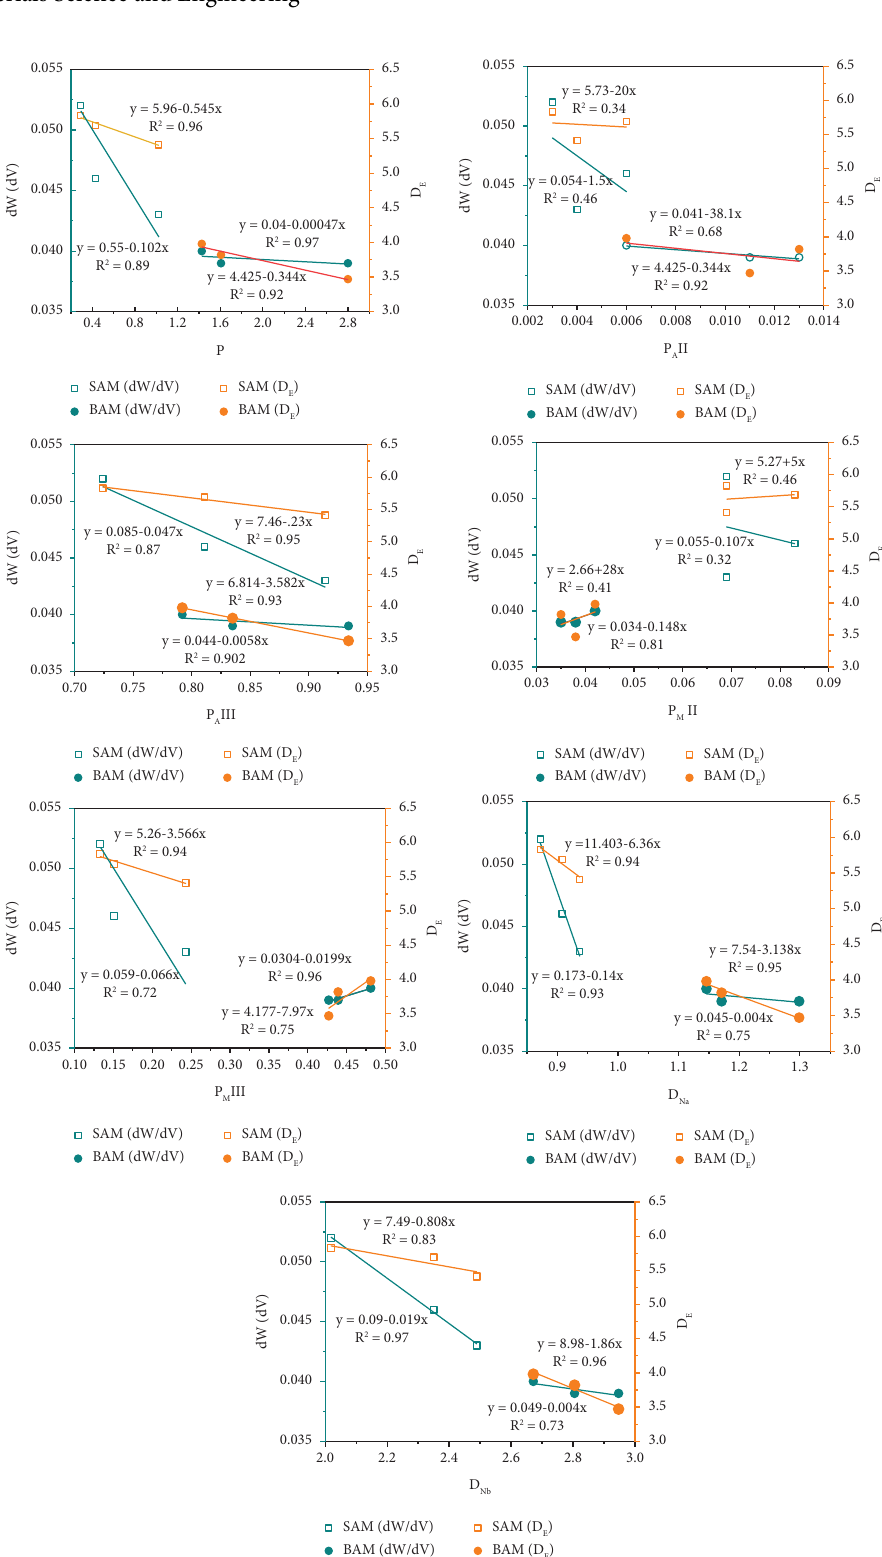
Figure 13: Fitting relationship between porosity and macrocrack resistance index of asphalt mixture at